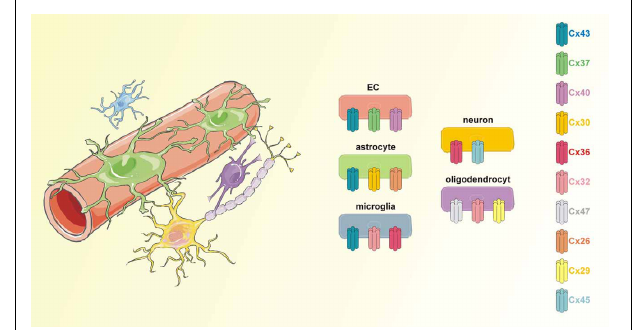
FIGURE 1 | Connexins in the neurogliovascular unit. The neurogliovascular unit is a functional unit in which astrocytes are centrally involved. Astrocytic endfeet are tightly associated with endothelial cells that form the BBB while at their other site, astrocytes contact pre- and postsynaptic neuronal membranes. Additionally, astrocytes may contact other glial cells like microglia and oligodendrocytes. Each of the cell types in the neurogliovascular unit is endowed with a set of connexins proteins. Importantly, Cx43 is present in astrocytes as well as in BBB endothelial cells and microglial